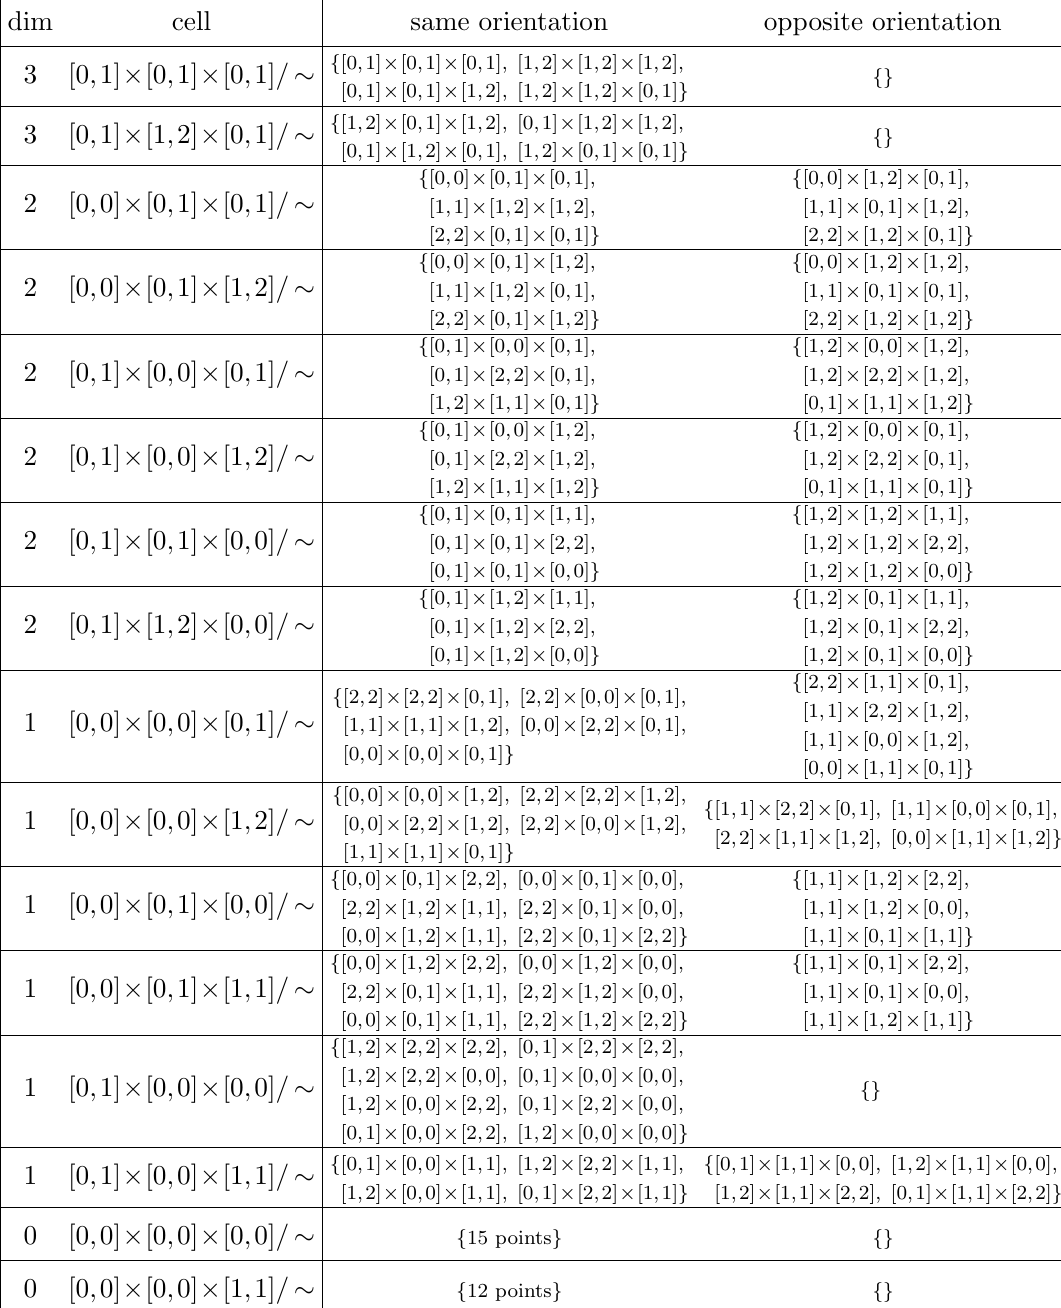
Table 1 . Cubical cell complex for Y . For each equivalence class, the cubical cells with the same and opposite orientation are